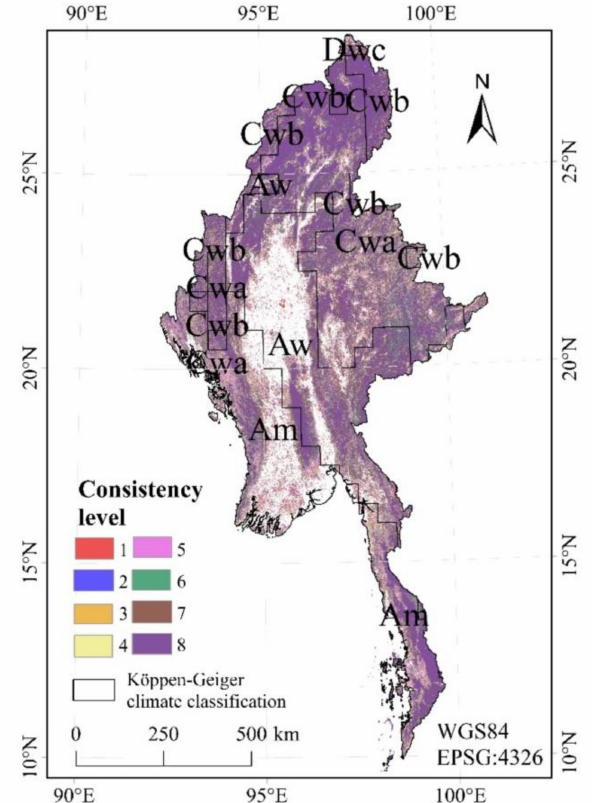
Figure 10. Spatial consistency of eight datasets with KÖPPEN-Geiger climate classification.